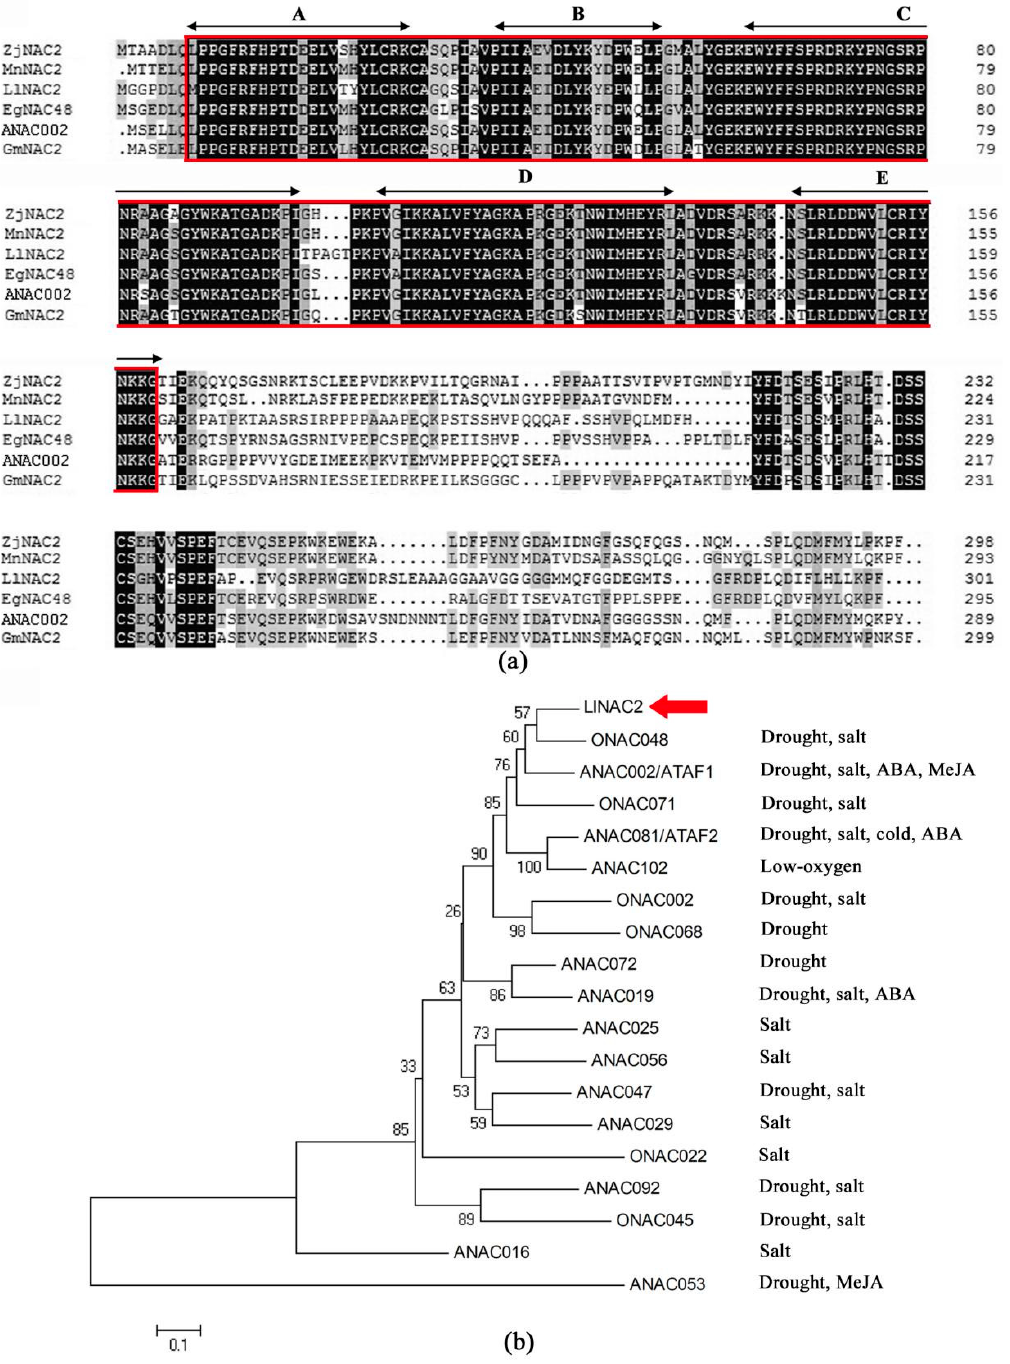
Figure 1. Characterization of LlNAC2. ( a ) Alignment of LlNAC2 with Ziziphus jujuba ZjNAC2, Morus notabilis MnNAC2, Elaeis guineensis EgNAC48, Arabidopsis ANAC002, and Glycine max GmNAC2. Black arrowed lines indicate the locations of the five highly conserved subdomains A–E. The conserved NAC domain is boxed and identical amino acids are shaded in black. ( b ) Phylogenetic tree analysis of LlNAC2 with other known stress-responsive NAC proteins. Protein sequences used in multiple sequence alignments and phylogenic tree analysis are shown in Supplementary Table S2.